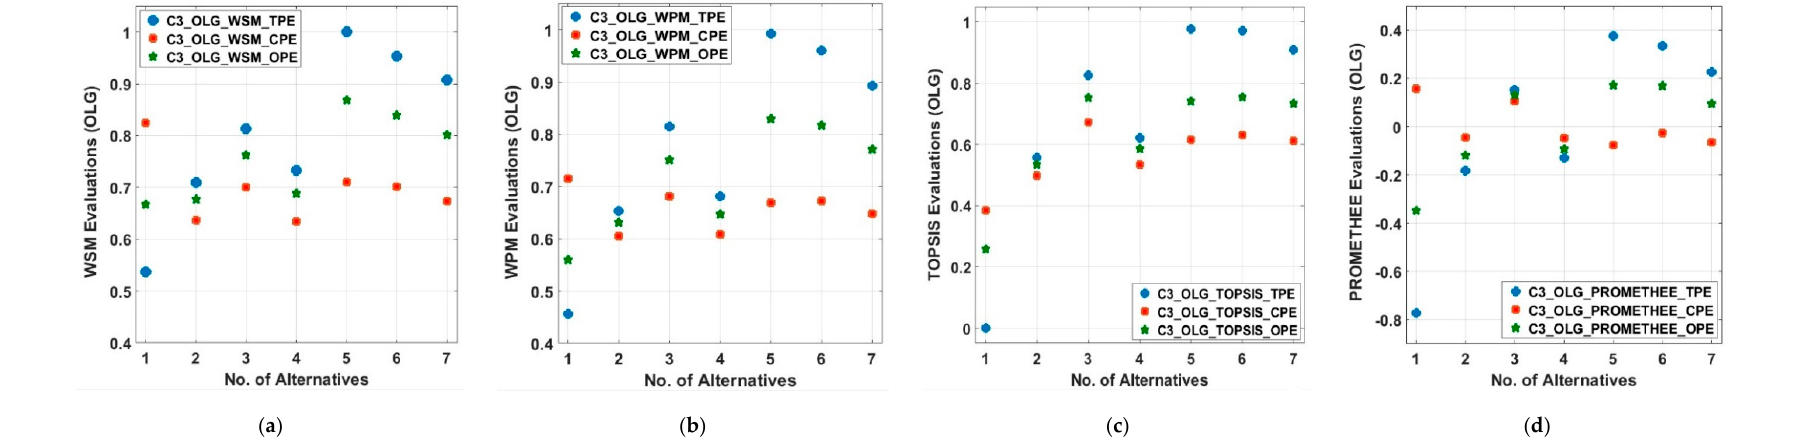
Figure 15. MCDM evaluations for C3_OLG in 33-bus MDN: ( a ) WSM scores; ( b ) WPM scores; ( c ) TOPSIS scores; ( d ) PROMETHEE scores. Table 26. Order of the ranks across TPE, CPE, and OPE in C3_OLG for 33-bus